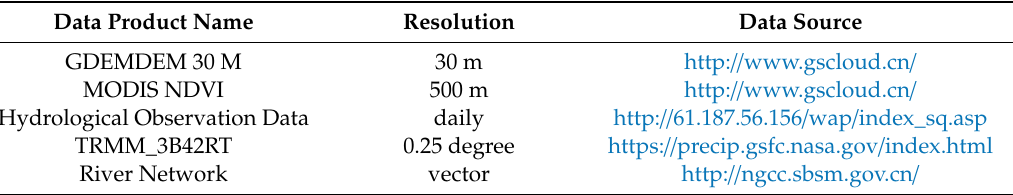
Table 1. Data sources of the